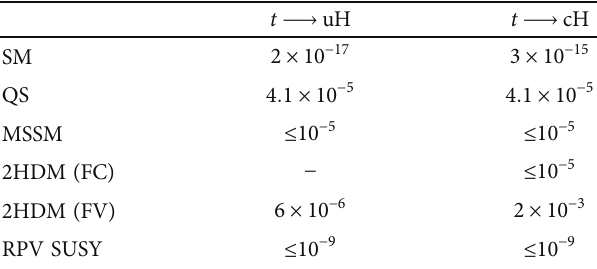
Table 1: Expected FCNC branching ratios from models [16].